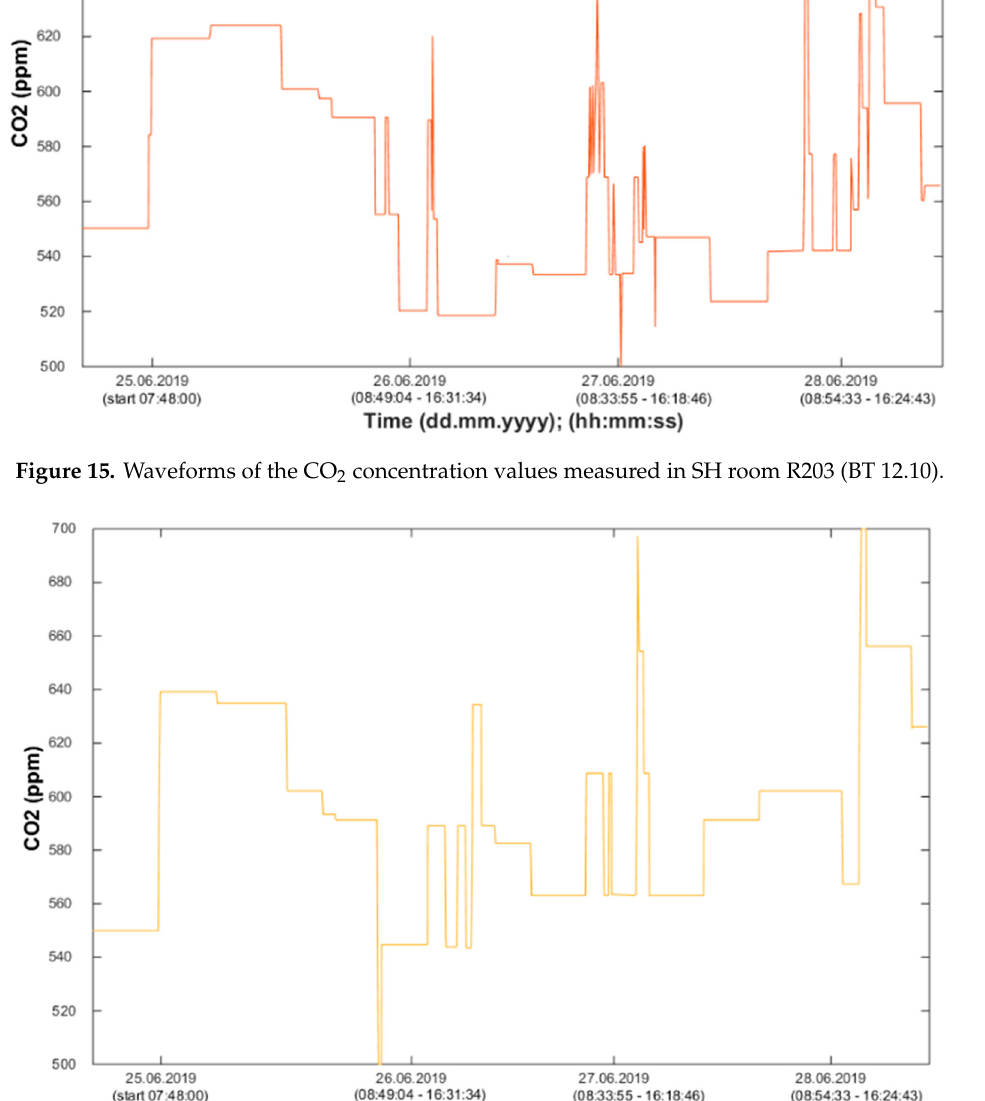
Figure 16. Waveforms of the CO 2 concentration values measured in SH room R204 (BT 12.11).